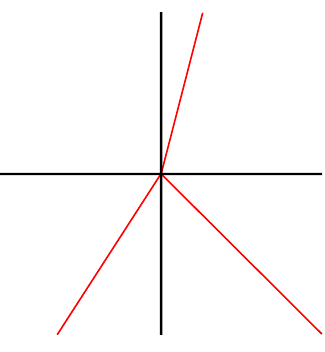
Figure 1 . The tropical hypersurface associated to g = 2 x 3